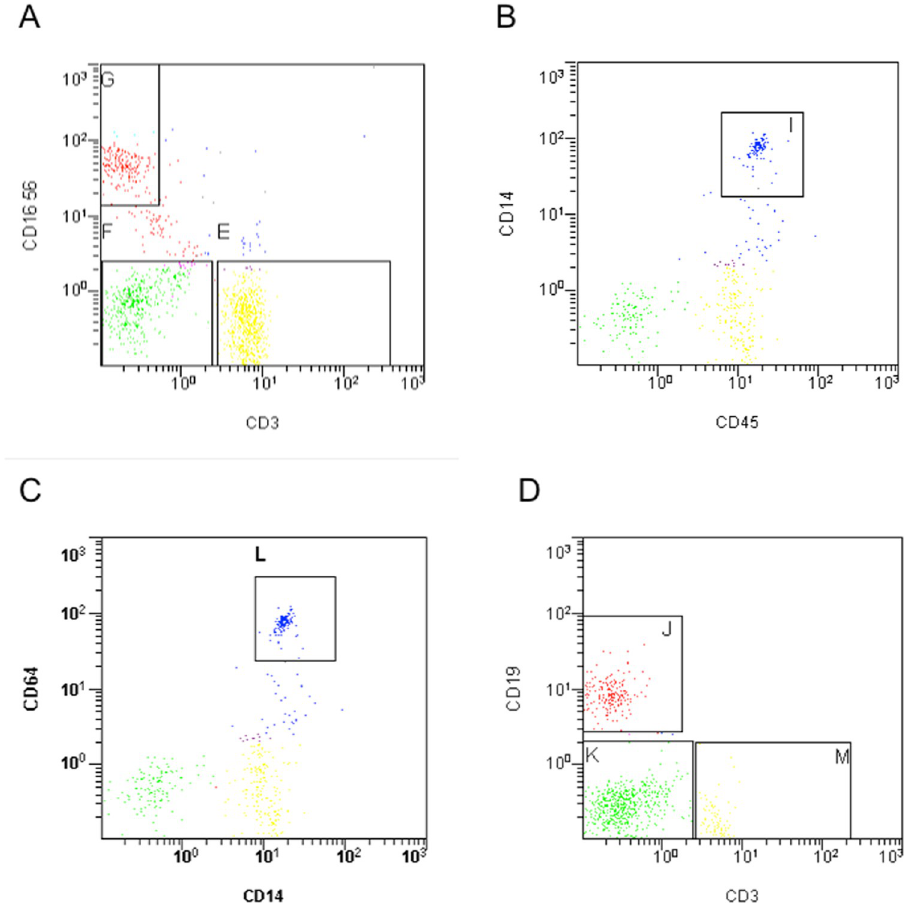
Fig 2. Representative plots from flow cytometric analysis. A) CD3+/16-/56- cells (gate E), CD16+/56+/3- cells (gate G); B) CD45+/14+ cells (gate I); C) CD14+/64+ cells (gate L); D) CD19+/3- cells (gate J). We gated for the whole population from the Lymphoprep isolation; forward and side scatter plots is available in the S1 Fig .